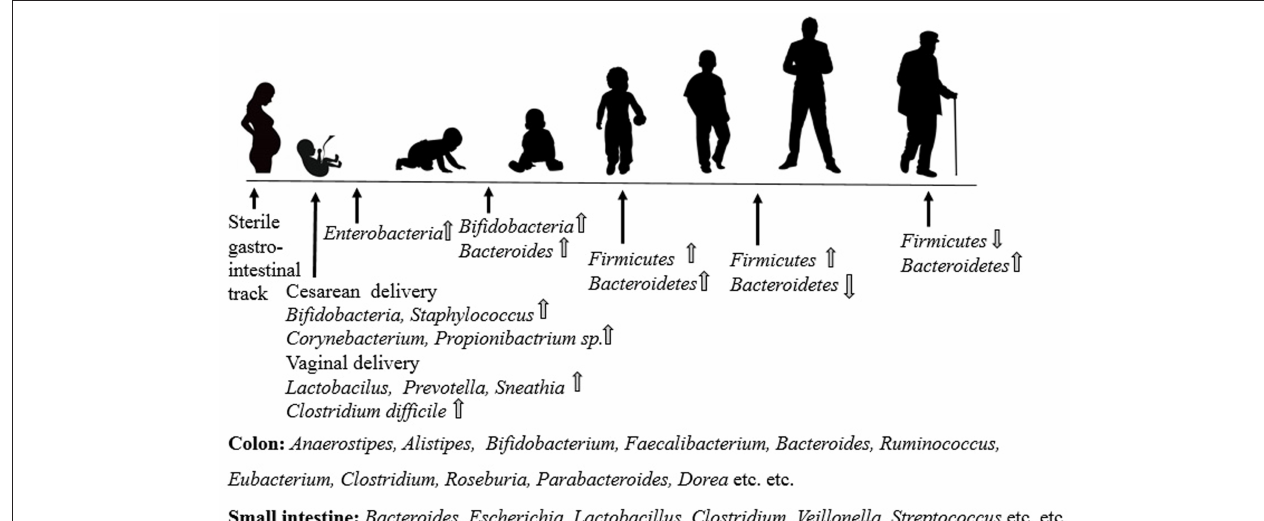
FIGURE 3 | Brief overview of the gut microbiota in different phases of life.